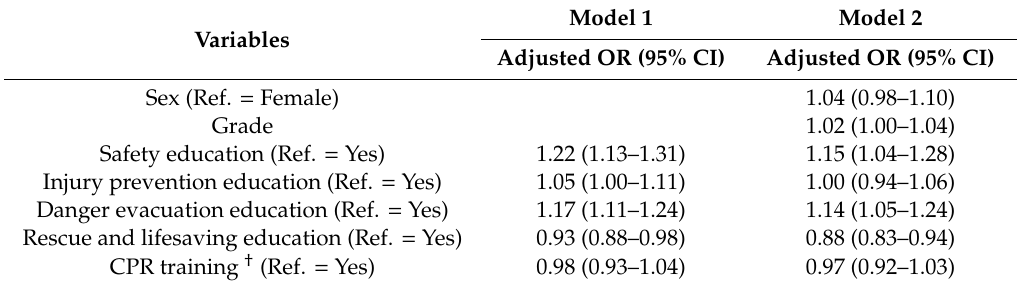
Table 8. The adjusted association of tooth fracture experience in the past 12 months with variables related to safety education experience in school by a complex-sample multivariable logistic regression